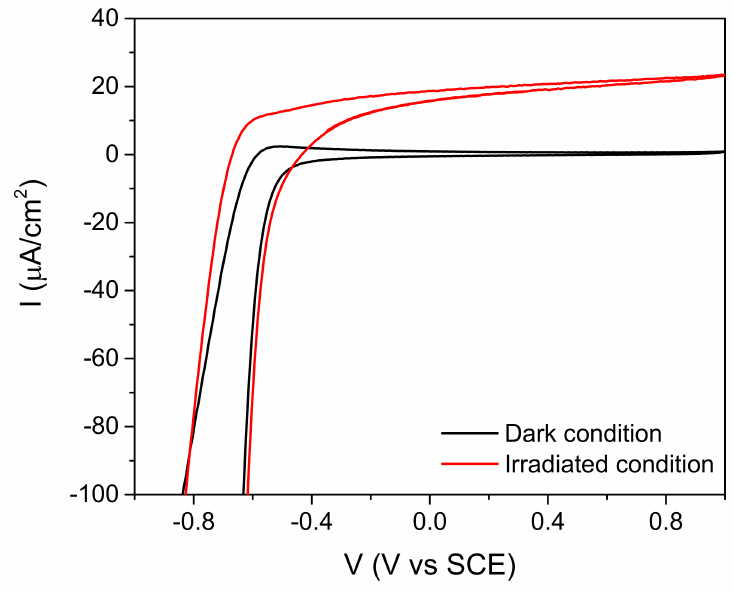
Figure 8. Effect of the irradiation on CV in supporting electrolyte performed at TiO 2